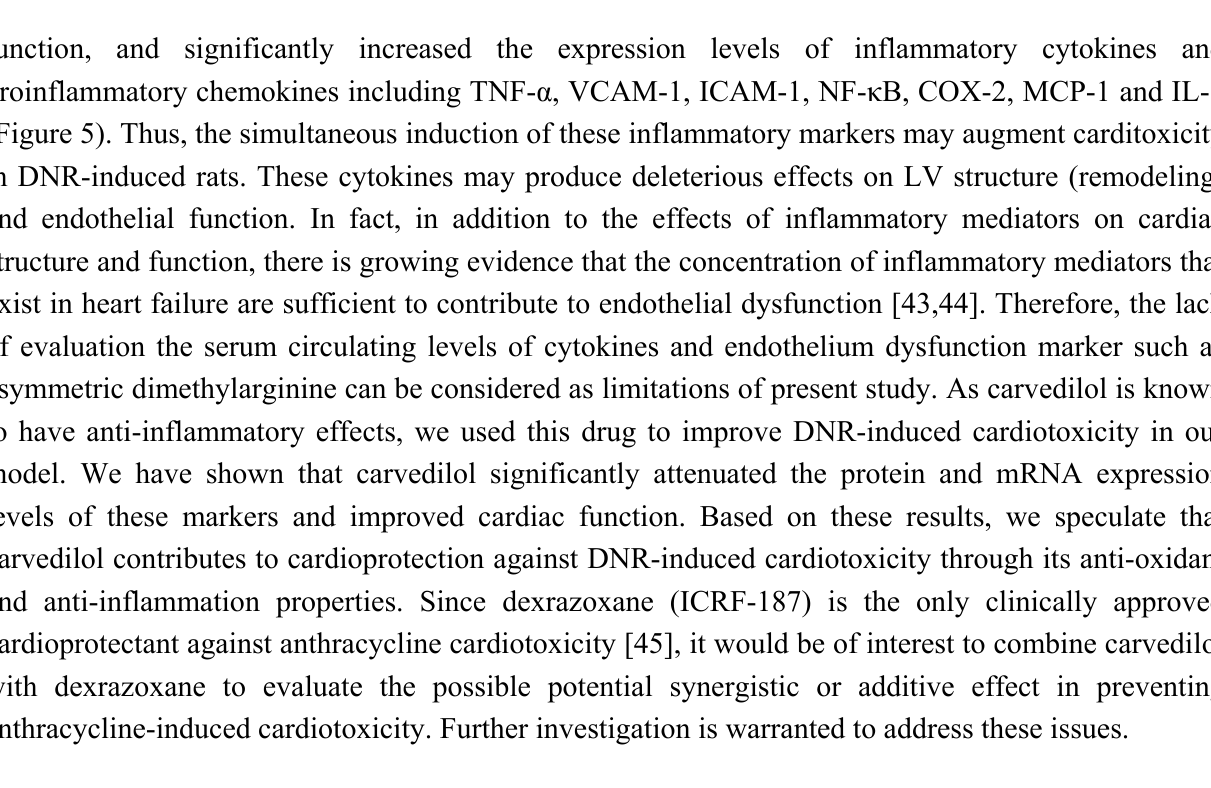
Figure 5. Scheme representing possible mechanism of carvedilol as an anti-inflammatory drug in DNR induced myocardial